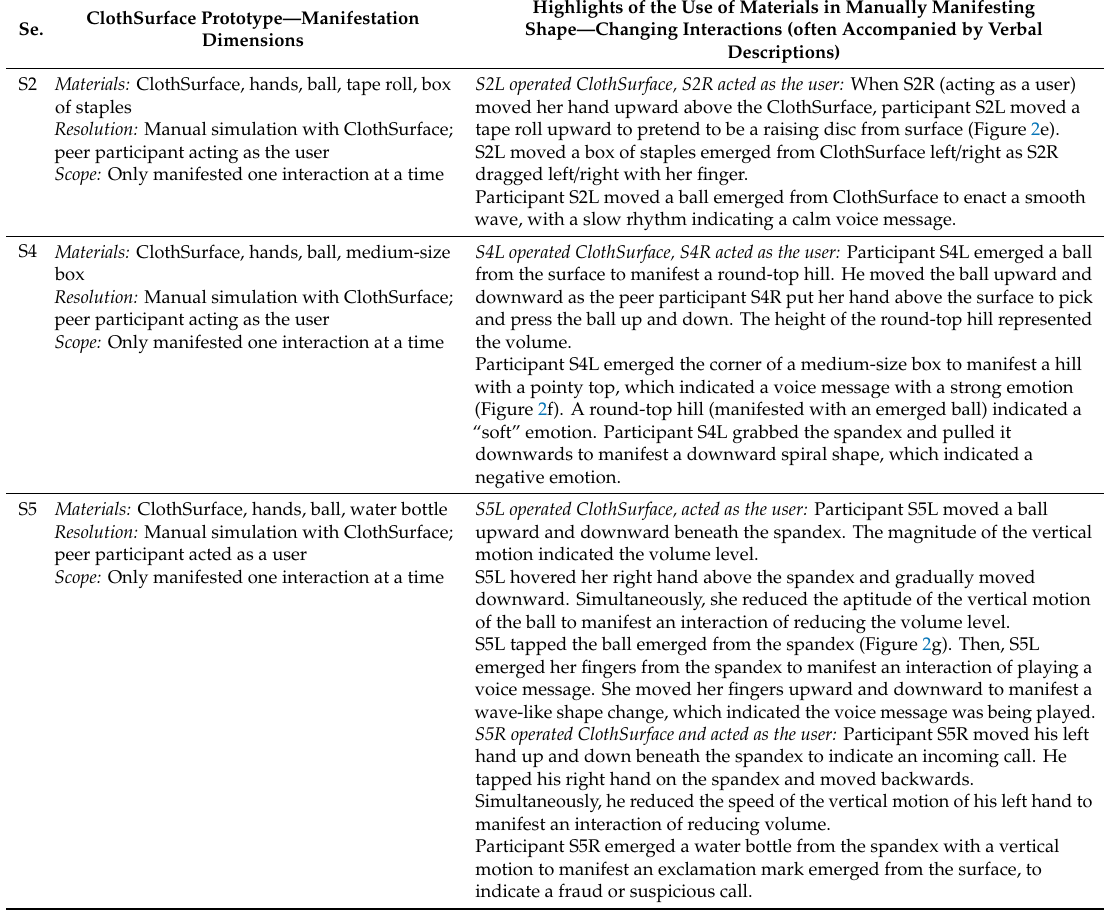
Table 2. Manifestation Dimensions and Use of Materials in the Sessions Assigned to the O ffi ce Phone Design Tasks (2A &